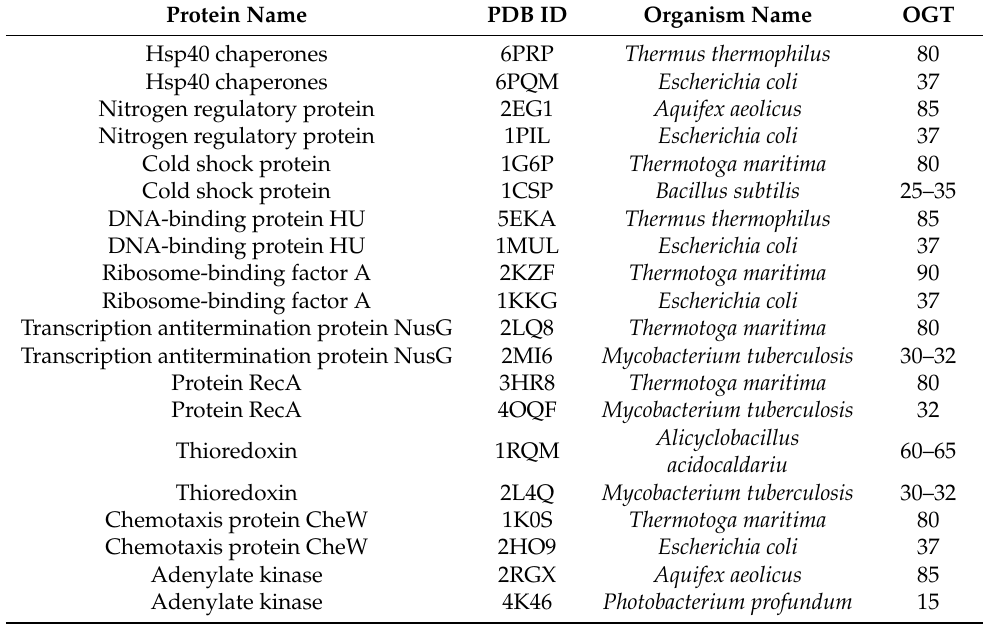
Table 4. Thermophilic proteins and their non-thermophilic